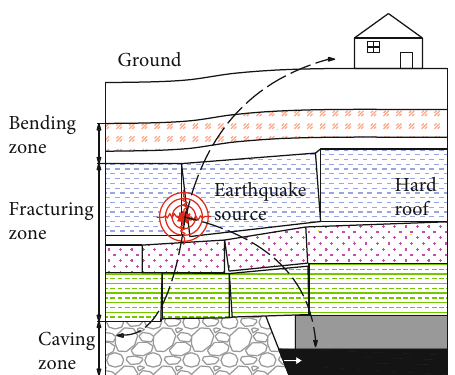
Figure 3: Schematic diagram of the mine earthquake induced by THR fracture.